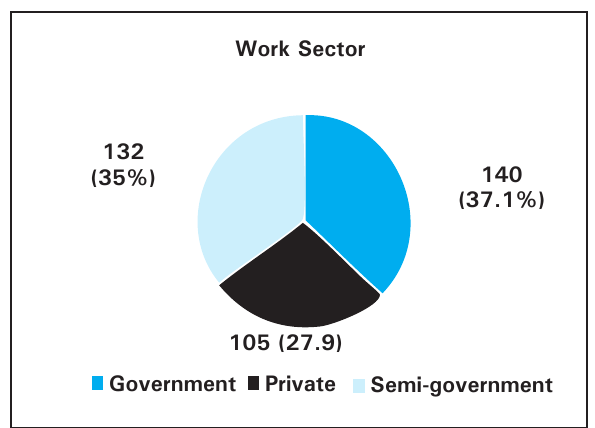
doctors.Government Private Semi-government Figure 1. Work sector of the participant The number of pregnant women encountered per week varied a lot depending upon specialties and experience level. In an average it was found to be 22 pregnant women per week (mean= 22.43). Specialties n (%)